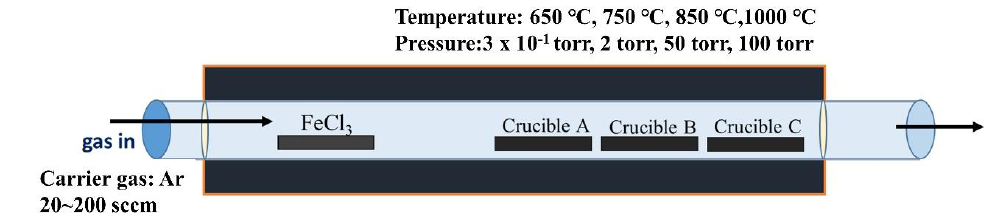
Figure 1. Schematic illustration of the CVD system, with FeCl 3 as precursors.